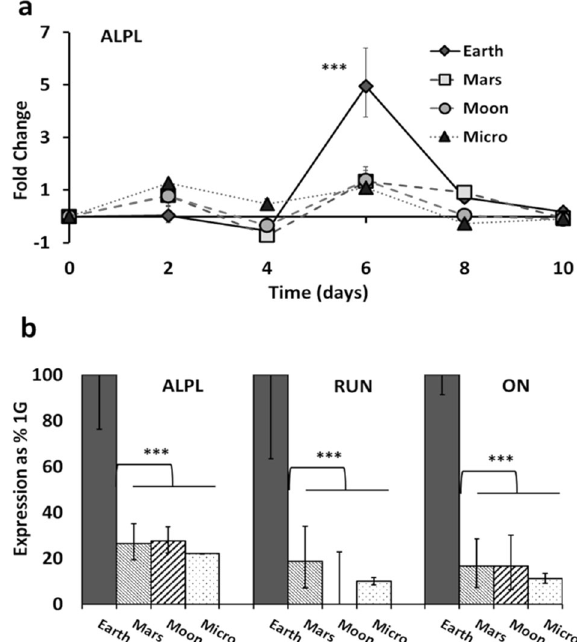
Fig. 3 Effects of simulated partial gravities on osteogenic marker gene expression. a Time course of ALPL gene expression for multiple simulated gravity conditions, following exposure of con fl uent 7F2 osteoblasts to osteogenic media. Relative expression was analyzed by real-time PCR and normalized to the levels of a housekeeping gene (GAPDH), with 1 G con fl uent cell culture (prior to osteogenic induction) as control. The relative expression of each gene to control is presented as a fold-change expression for each transcript. b Inhibition by simulated partial gravity of the three osteogenic marker genes is best discernable at the peak of their expression at day-6 Alkaline phosphatase (ALPL), Runt-related Transcription Factor 2 (RUN), Sparc/osteonectin (ON). Data are presented as means ± standard deviation. Values are means ± SD of three independent cultures. Asterisk (*) shows p < 0.05, (**) shows p < 0.01, (***) p < 0.001 as determined by Tukey ’ s post hoc